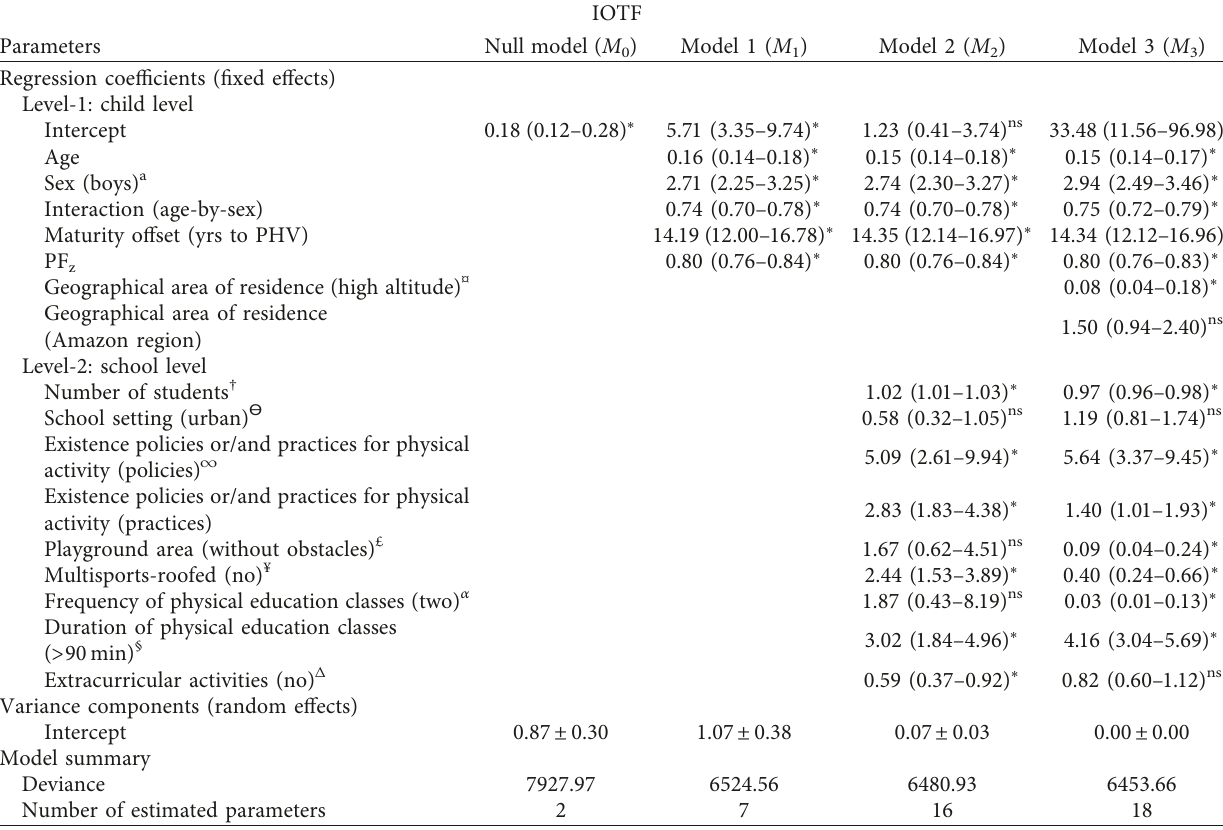
Table 6: Multilevel modelling results: odds ratios (OR) and 95% confidence intervals (95% CI) for child- and school-level